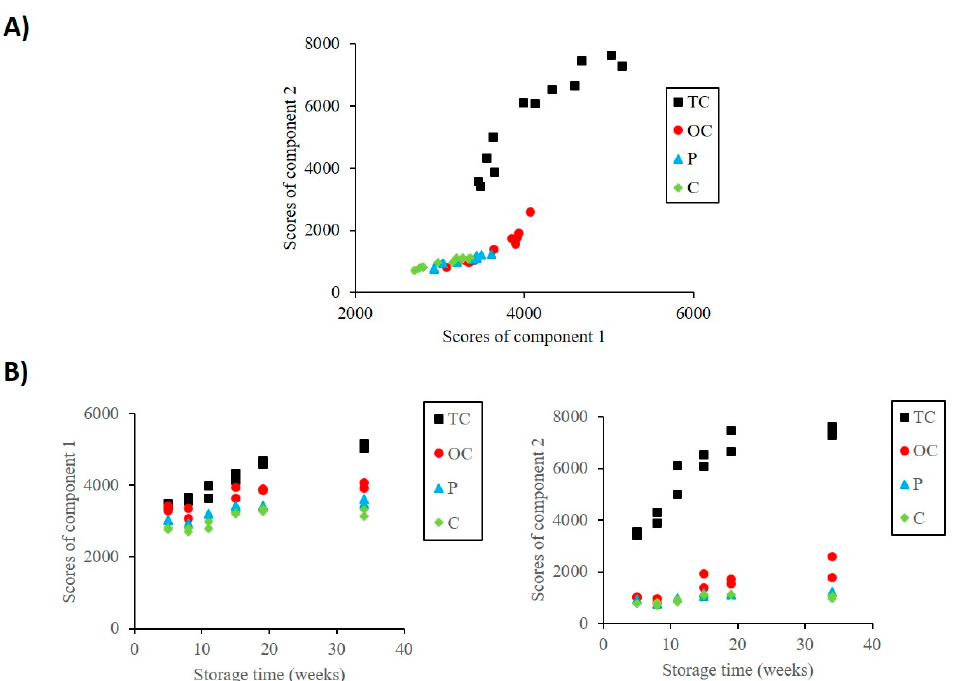
Figure 4. ( A ) PARAFAC scores of all the samples in different containers throughout the entire storage time. ( B ) Evolution of scores 1 and 2 across storage time.